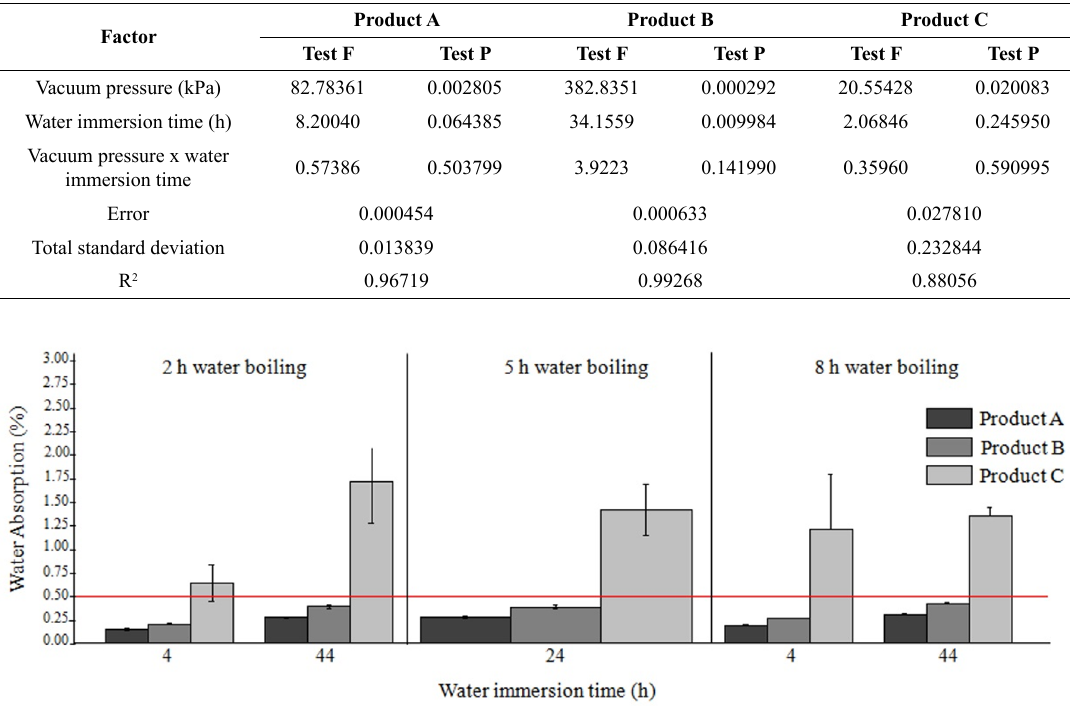
Figure 4. WA in function of the water immersion time obtained by the standard ASTM C373 for different water boiling times. Table 5. Analysis of variance (ANOVA) applied to the WA values in relation to the boiling time and water immersion time.